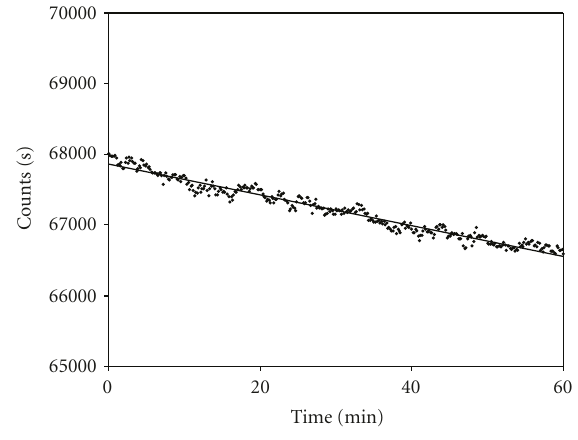
Figure 3: Baseline drift over a period of one hour after thermal stability achieved.